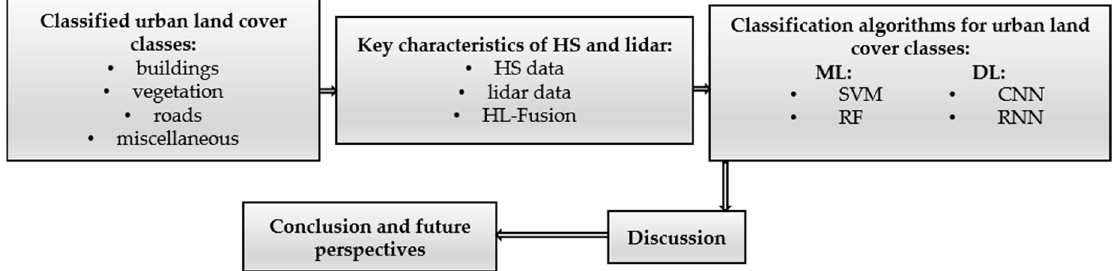
Figure 1. The structure of the review paper.